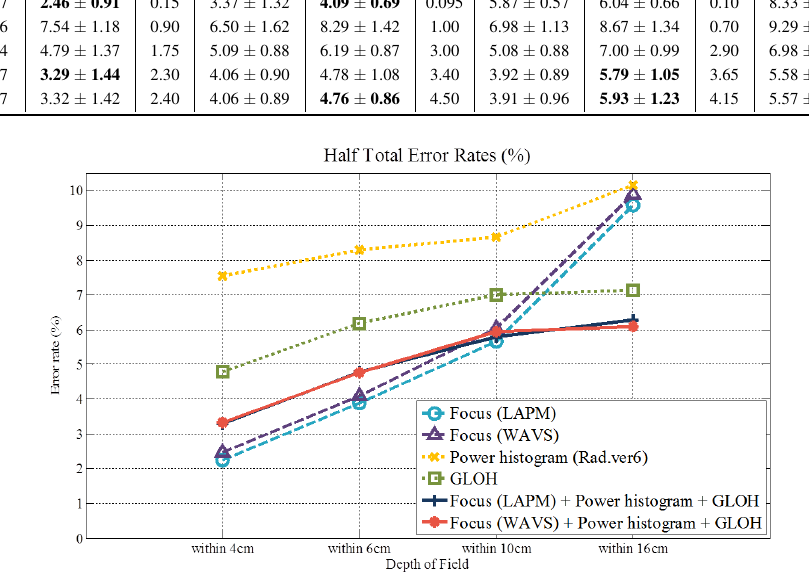
Figure 21. HTERs (%) of features.